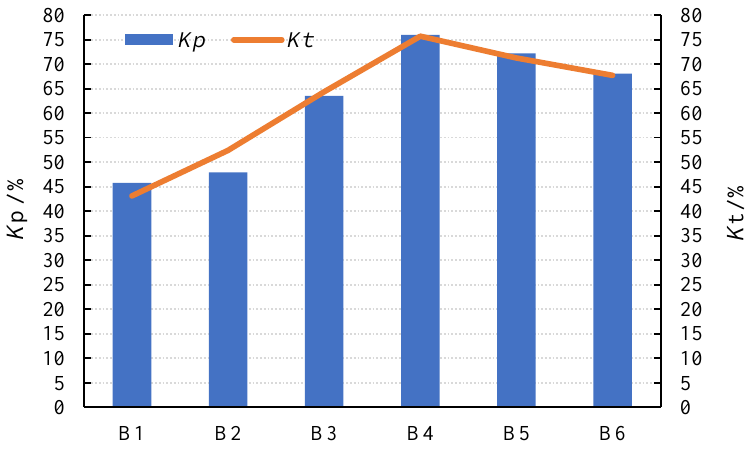
Figure 12. Electromechanical coupling performance.